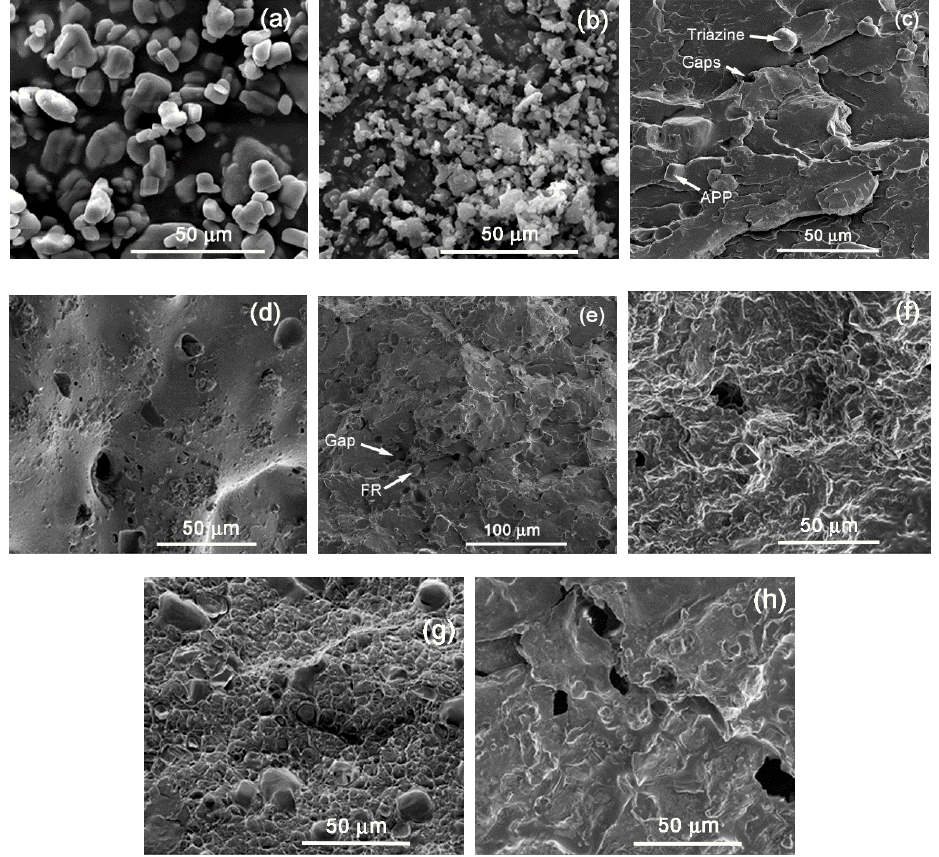
Figure 5. Comparison between FR3-containing fractured surfaces of UL94 bars: ( a ) Neat APP, ( b ) neat Triazine, ( c ) LDPE-A/FR3 prior to UL 94, ( d ) LDPE-A/FR3 char after UL 94, ( e ) LDPE-T/FR3 prior to Triazine, ( c ) LDPE-A / FR3 prior to UL 94, ( d ) LDPE-A / FR3 char after UL 94, ( e ) LDPE-T / FR3 prior to UL 94, ( f ) LDPE-T/FR3 char after UL 94, ( g ) LLDPE/FR3 prior to UL 94, and ( h ) LLDPE/FR3 char after UL 94, ( f ) LDPE-T / FR3 char after UL 94, ( g ) LLDPE / FR3 prior to UL 94, and ( h ) LLDPE / FR3 char after UL 94. UL